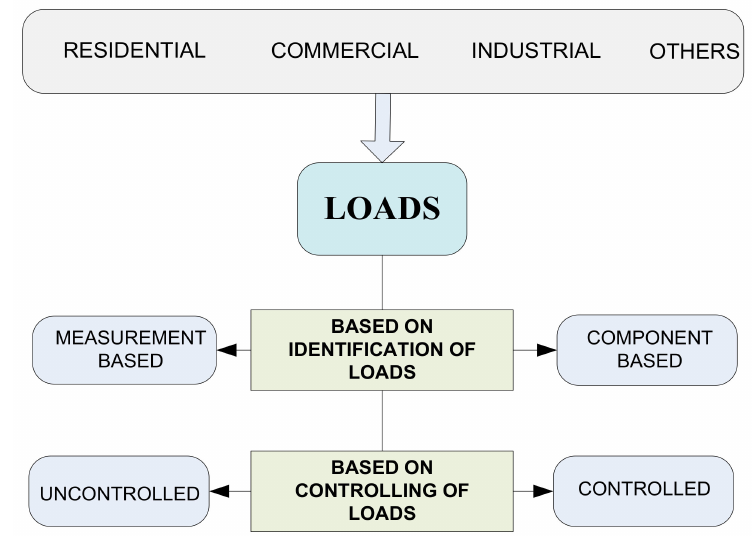
Figure 2. Loads classification is based on identification and control.